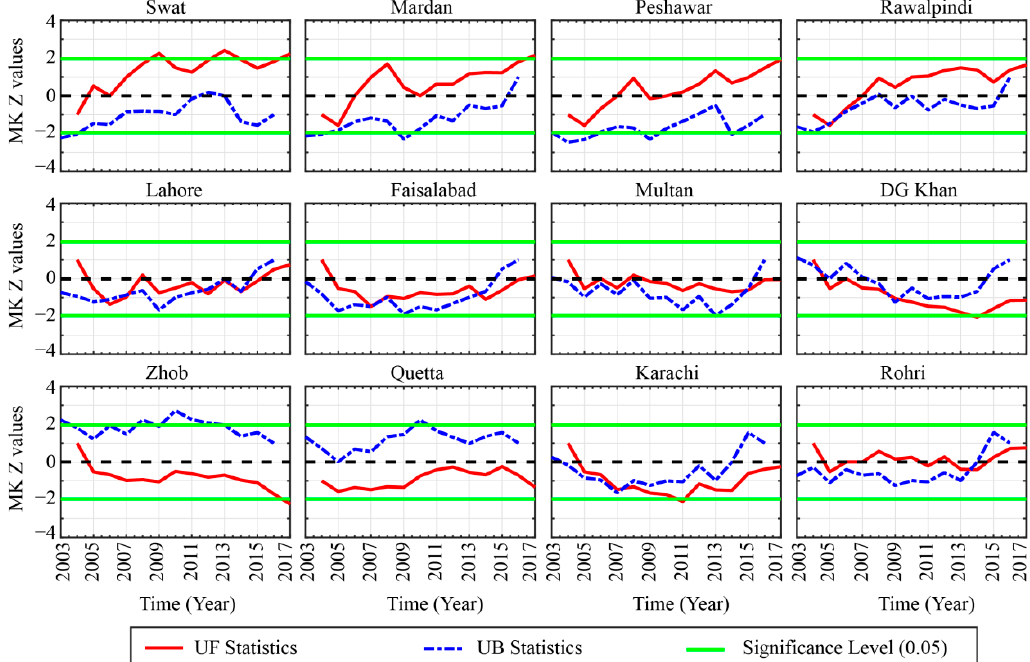
Figure 6. Abrupt changes of annual mean aerosol optical depths during 2003–2017 over the selected locations. Atmosphere 2020 , 11 , x